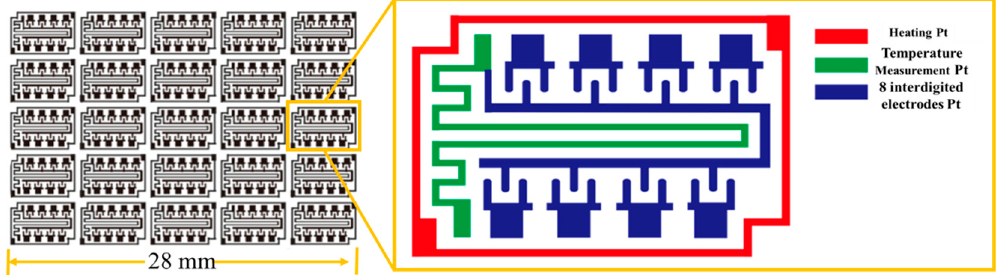
Figure 3. The structure of the 8-matrices material substrate.